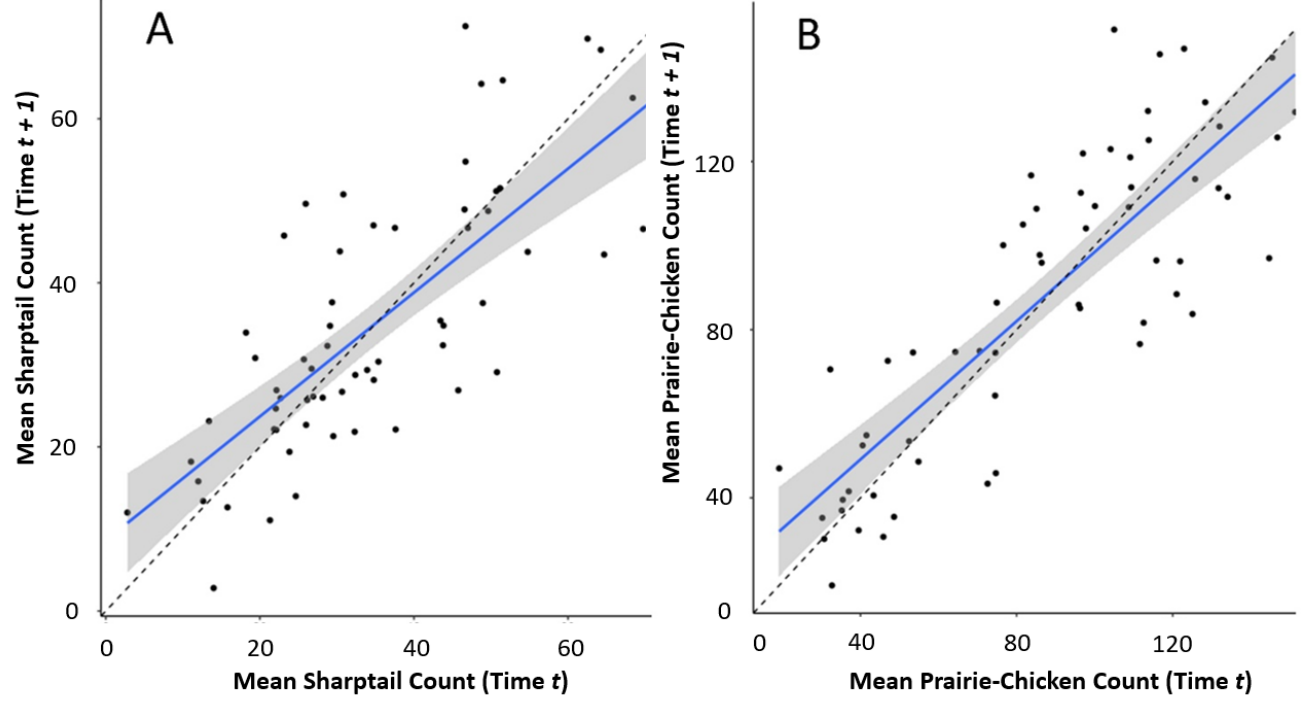
Figure 4. Scatter plots of ( A ) sharptail and ( B ) prairie-chicken mean breeding ground counts from consecutive years between 1956 and 2018 in the Sandhills of Nebraska, USA. The dashed lines represent a 1:1 relationship (counts from consecutive years have identical values). Trend lines are linear models with 95% confidence intervals.